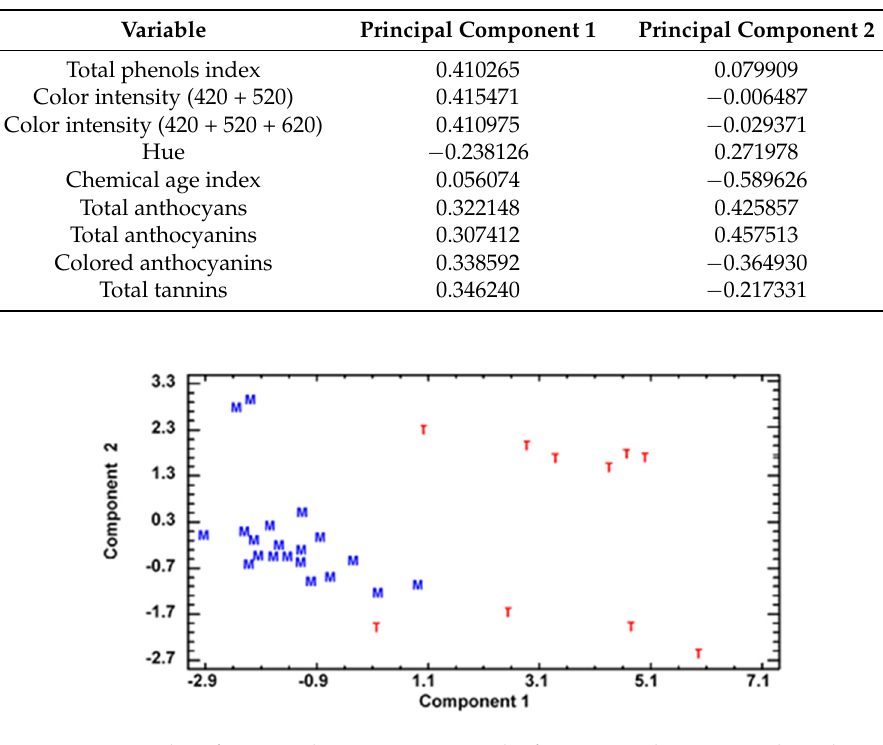
Table 4. Weight of the nine variables determined by spectrophotometry for Mencia and Alicante Bouschet wines in the principal components 1 and 2.